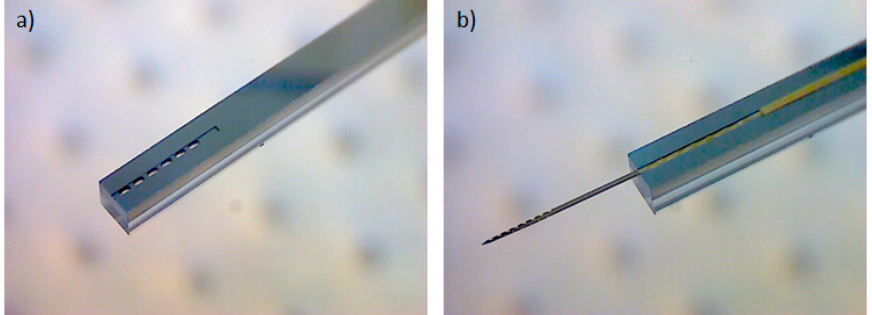
Figure 9. Side view of the silicon-based vacuum-actuated insertion tool (1 mm wide, 0.9 mm thick, and 40 mm long) with an integrated microfluidic channel ( a ) and a vacuum-fixed floating neural probe for complete and precise insertion of the silicon-stiffened shaft into the cortex ( b ).